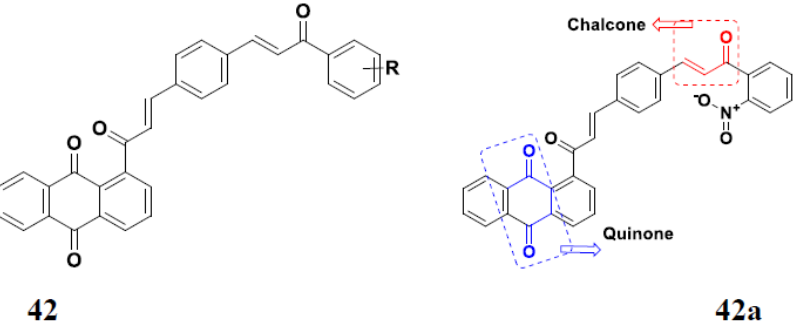
Figure 47. Structure of quinone ‐ based chalcone hybrids and the most promising compound 42a. Table 35. In vitro cytotoxic activities of quinone based chalcone hybrid compounds 42 ( b – e ).